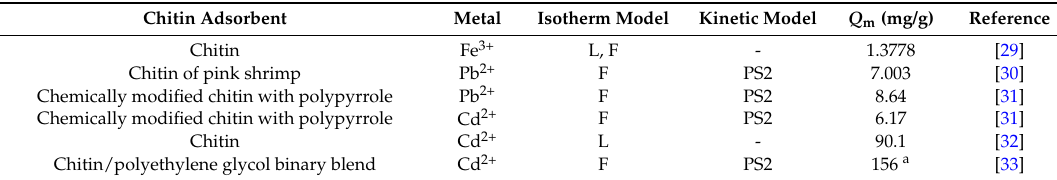
List of models for adsorption isotherms and kinetics for adsorption of metals on chitin-based